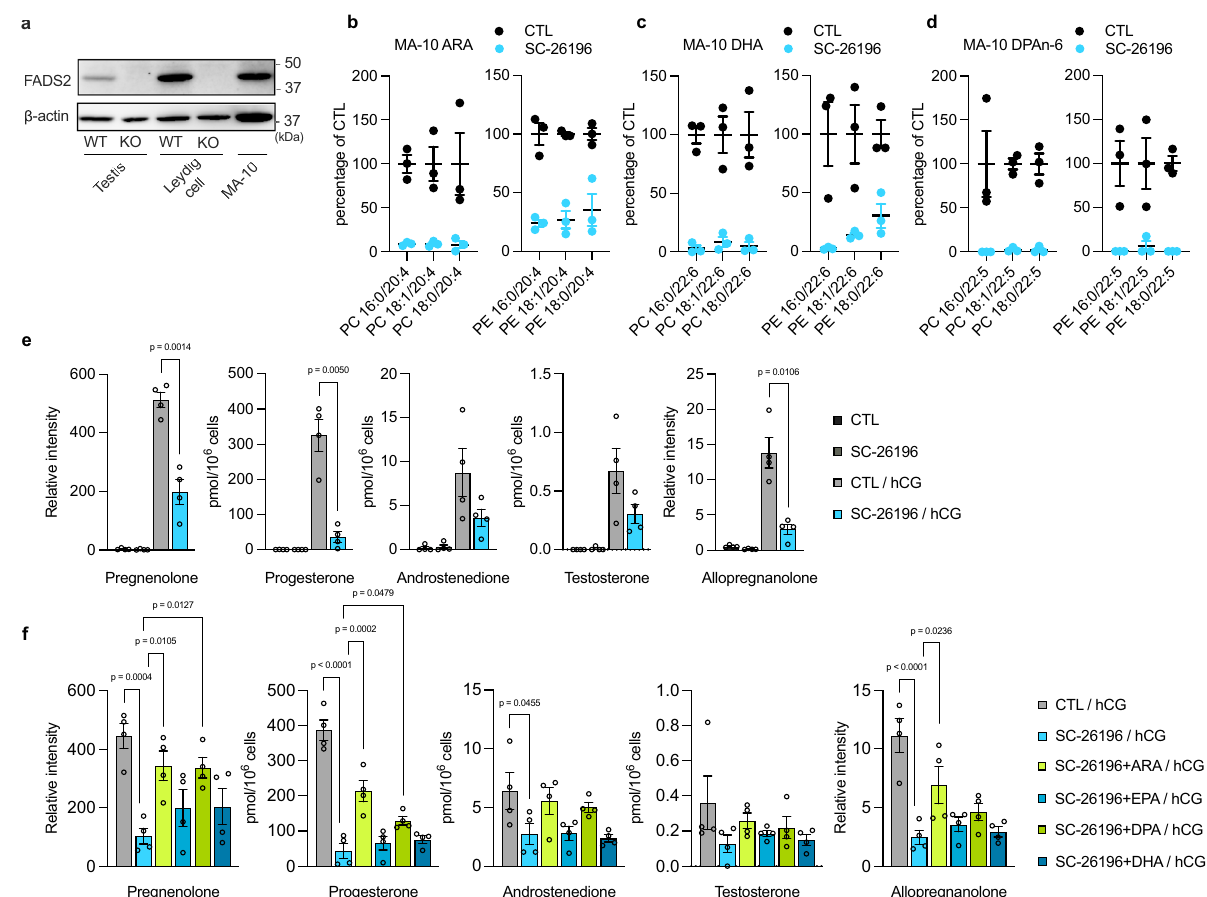
Fig. 3 Omega-6 HUFAs are required for steroid hormone production in MA-10 cells. a Immunoblotting using anti-mouse FADS2 antibody of samples from testes and Leydig cells from FADS2 + / + (WT) and FADS2 − / − (KO) mice and MA-10 cells. β -actin was used as a loading control. b – d Quanti fi cation of HUFA species in MA-10 cells. The values of each molecular species were expressed as a percentage relative to CTL. n = 3 for each group. The detailed lipidomics data are shown in Supplementary Fig. 4. e Reduced steroid hormone production in MA-10 cells treated with SC-26196. Steroid hormones were extracted from the supernatant. n = 4 for each group. Signi fi cance is based on unpaired two-tailed t -test with Welch ’ s correction. f Steroid hormone production in MA-10 cells supplemented with HUFAs. Steroid hormones were extracted from the supernatant. n = 4 for each group. Signi fi cance is based on Dunnett ’ s multiple comparisons test. Data shown are the mean ± SEM. Steroid hormone levels in the cell pellets are shown in Supplementary Fig. 4f. CTL control, hCG human chorionic gonadotropin, ARA arachidonic acid, EPA eicosapentaenoic acid, DHA docosahexaenoic acid, DPA n-6 docosapentaenoic